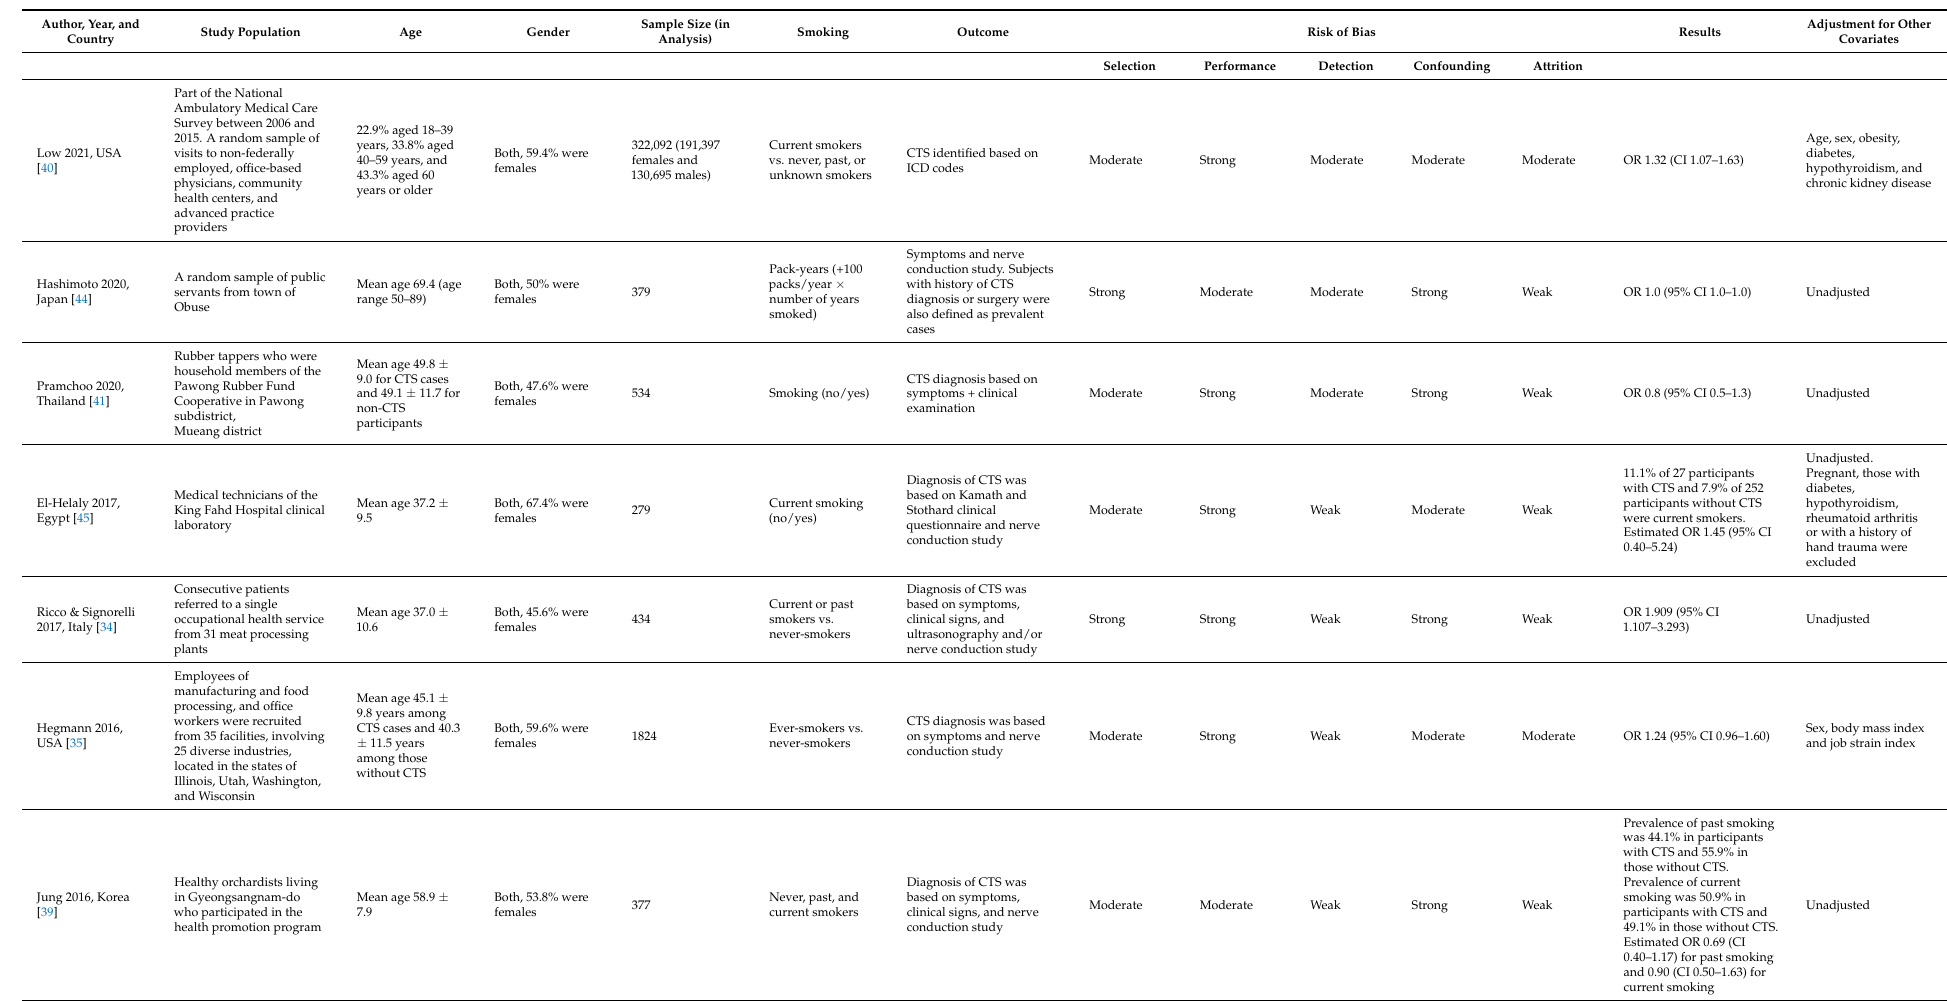
Table A2. Cross-sectional studies included in